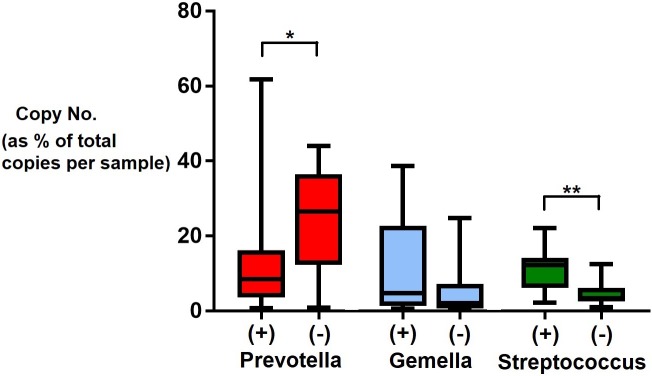
Microbial loads from qPCR.qPCR-derived copy numbers of each genera were expressed as a percentage of total microbial copy number within each sample. Twenty samples were randomly selected for each disease status. Statistical significance is indicated by (*P < 0.01) or (**P < 0.001) as determined by Mann-Whitney U test.